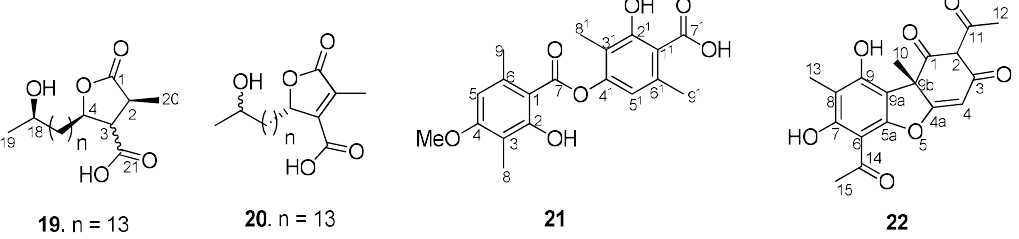
Figure 3. Isolated compounds from Usnea longissima acetone extract.